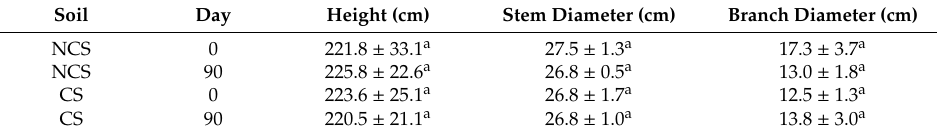
Table 3. Plant size at the beginning and at the end of the phytoremediation period.